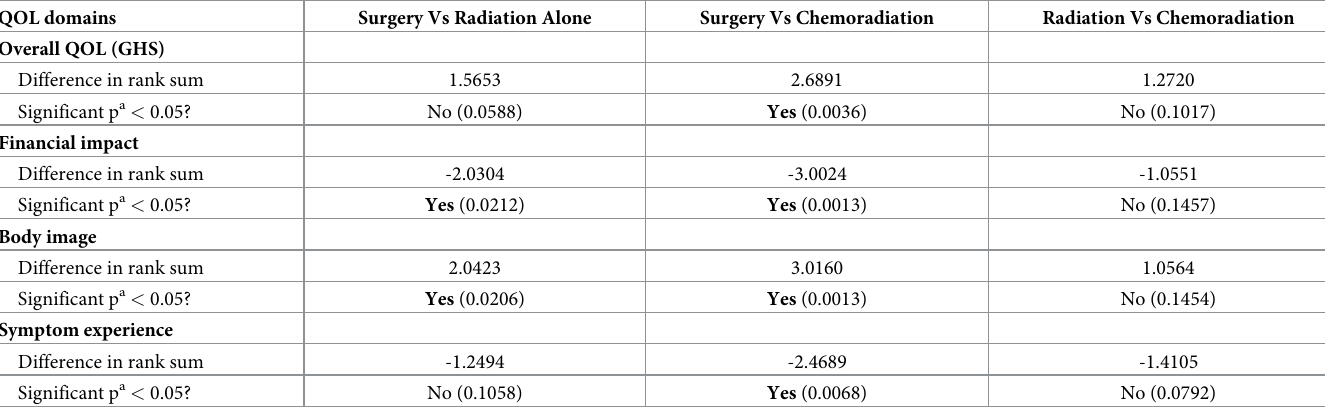
Table 5. Dunn’s post hoc test of selected QoL domains and primary